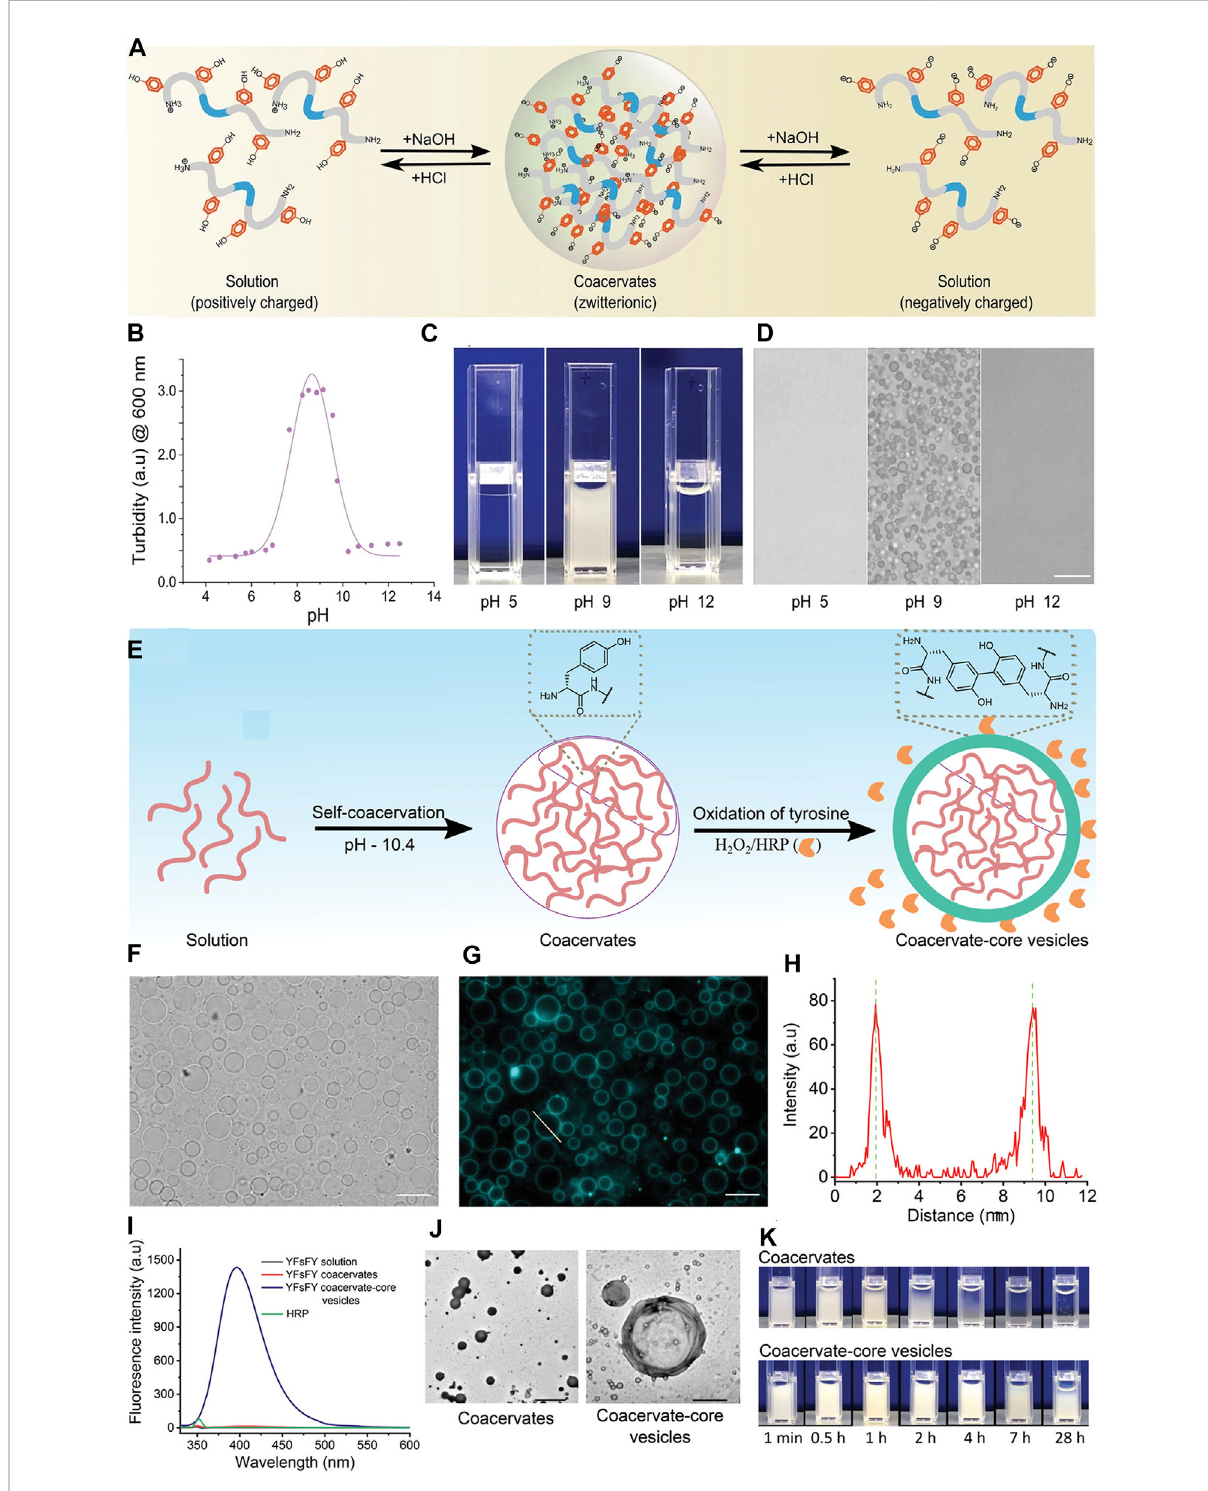
The in fl uence of pH. (A) Schematicillustration of YFsFY in solution at pH 4 (positively charged), in coacervates atpH 9 (zwitterionic form) and in solution atpH 12(negativelycharged). (B) Turbidityof1 mg ml − 1 YFsFYas afunctionofpHwith constant saltconcentrationof65× 10 – 3 Mshowsthe formationofcoacervatesinapHwindowbetween7and10.5.Thesolidlineisa fi toftheturbiditydatatoa2-pK a model. (C) Appearanceof2 mg ml − 1 YFsFY solutionatpH5, 9,and 12. (D) Bright- fi eldoptical microscopyofthesamplesin (C) showsthepresenceofcoacervatesatpH9.The